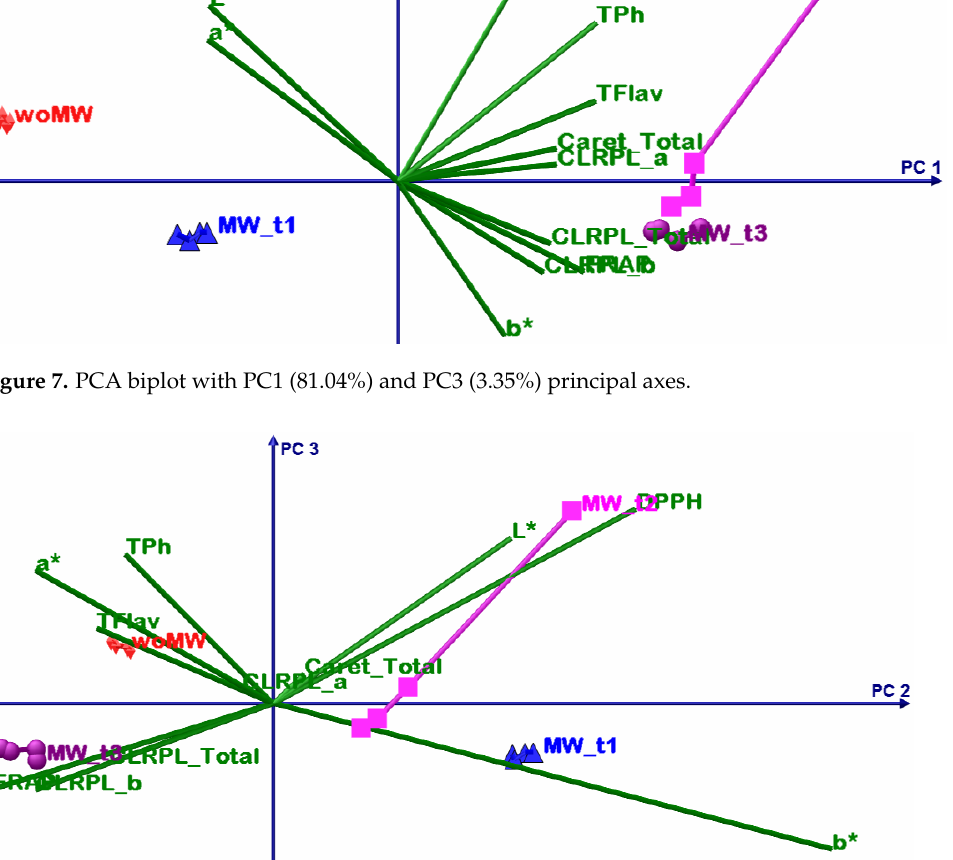
Figure 8. PCA biplot with PC2 (15.59%) and PC3 (3.35%) principal axes.